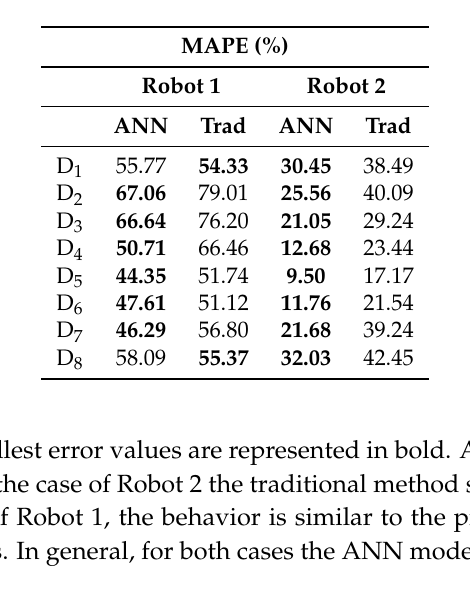
Table 1. Mean Absolute Percentage Error for both models and robots